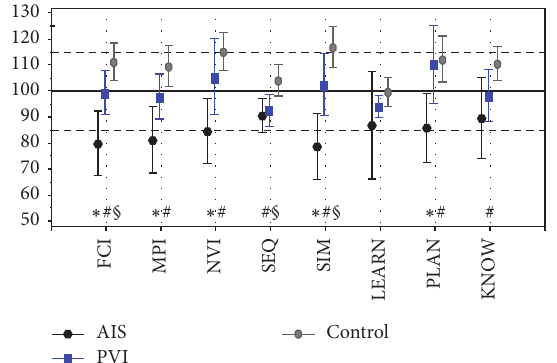
Figure 3: Mean with 95% CI Kaufman Assessment Battery for Children, Second Edition index with the subscale scores for children with periventricular venous infarction (PVI), arterial ischemic stroke (AIS), and controls. The FCI stands for Global Fluid- Crystallized Index (includes all subscales); MPI stands for Mental Processing Index (excludes acquired knowledge); NVI stands for Nonverbal Index; SEQ stands for Sequential Processing; SIM stands for simultaneous processing; LEARN stands for learning;